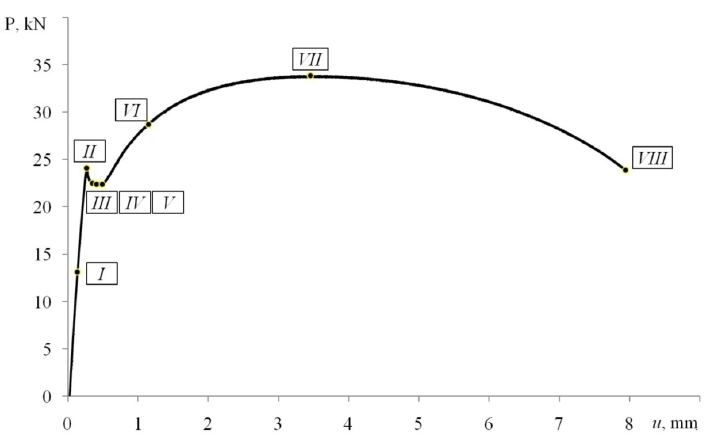
Figure 2: The tensile test diagram for carbon steel.